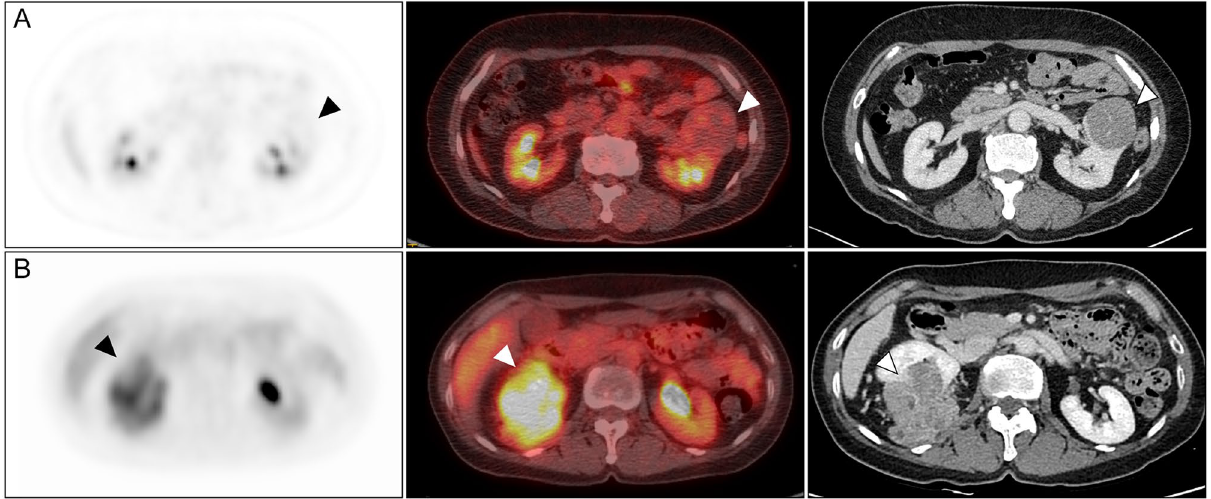
Figure 1. RCC with low and high MTV. Upper row: a 66-year-old female had a renal mass (arrowhead) with low 18 F-FDG uptake (SUV max : 2.98, MTV: 1.44 cm 3 ). The pathological T stage was T1b. Lower row: a 63-year-old female had a renal mass (arrowhead) with high 18 F-FDG uptake (SUV max : 6.85, MTV: 99.16 cm 3 ). The pathological T stage was T3a. RCC renal cell carcinoma, FDG fluorodeoxyglucose, SUV max maximum standardised uptake value, MTV metabolic tumour volume.